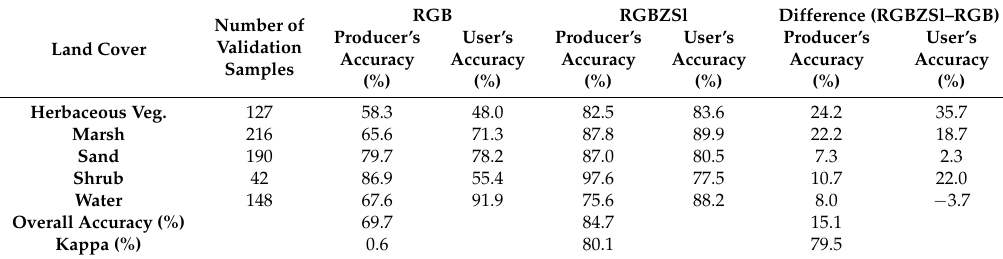
Table 3. Average producer’s accuracy, user’s accuracy, overall accuracy, and kappa coefficient from classifications run at four different resolutions using visual (RGB) and visual and topographic (RGBZSl) data. Producer’s accuracy is the percent of the total pixels in a given reference class that were correctly classified in the output image. User’s accuracy is the percent of all output image pixels in a given class that were correctly classified. The last two columns present differences in accuracy and were calculated by subtracting the RGB accuracy value from the corresponding RGBZSl value. The negative value indicates that the RGB classification produced a greater user’s accuracy for the water class than the RGBZSl